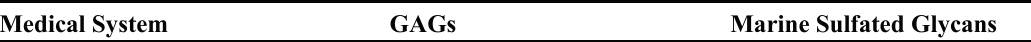
Table 3. Medical effects of exogenous GAGs and marine sulfated glycans of well-defined chemical structures in different pathophysiological